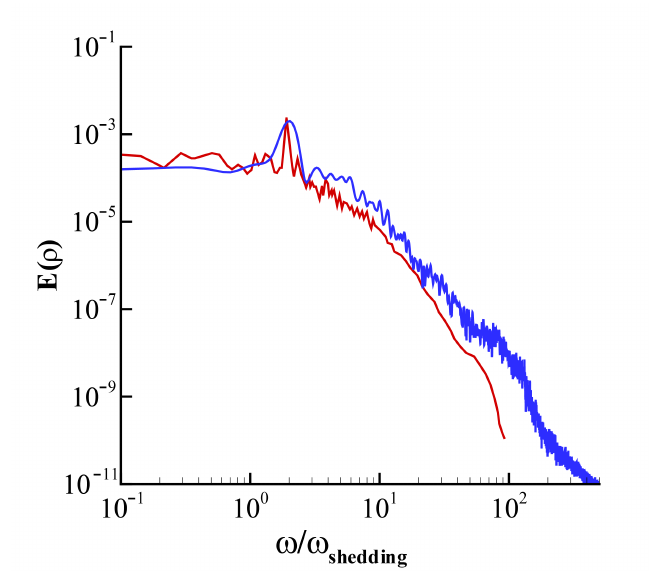
Figure 9. Density spectra at wake centerline x = 2 D . E ( ρ ) denotes nondimensionalized density spectra using freestream velocity, freestream density, and D , while nondimensional frequencies are normalized by the Strouhal